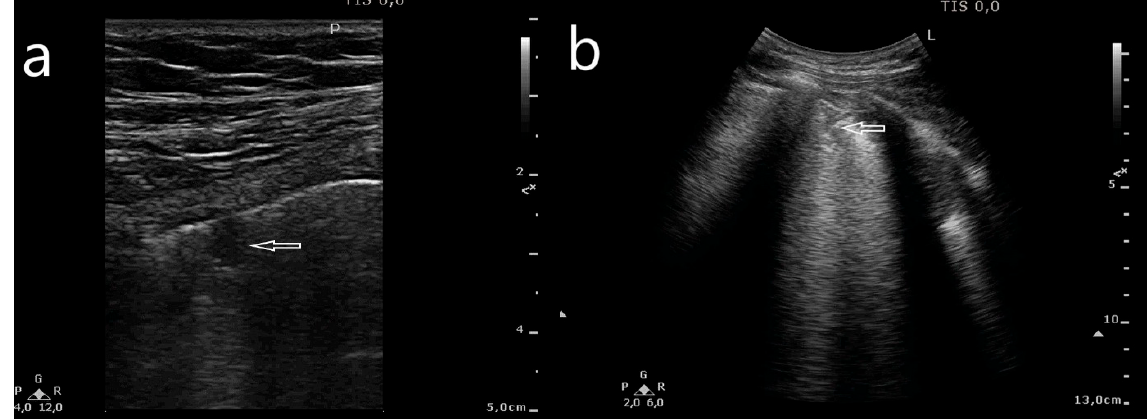
Figure 4. Subpleural consolidation, oval ( a ) and wedge-shaped ( b ), with a C-line artifact arising from the bottom margin of the subpleural consolidation (horizontal arrows).